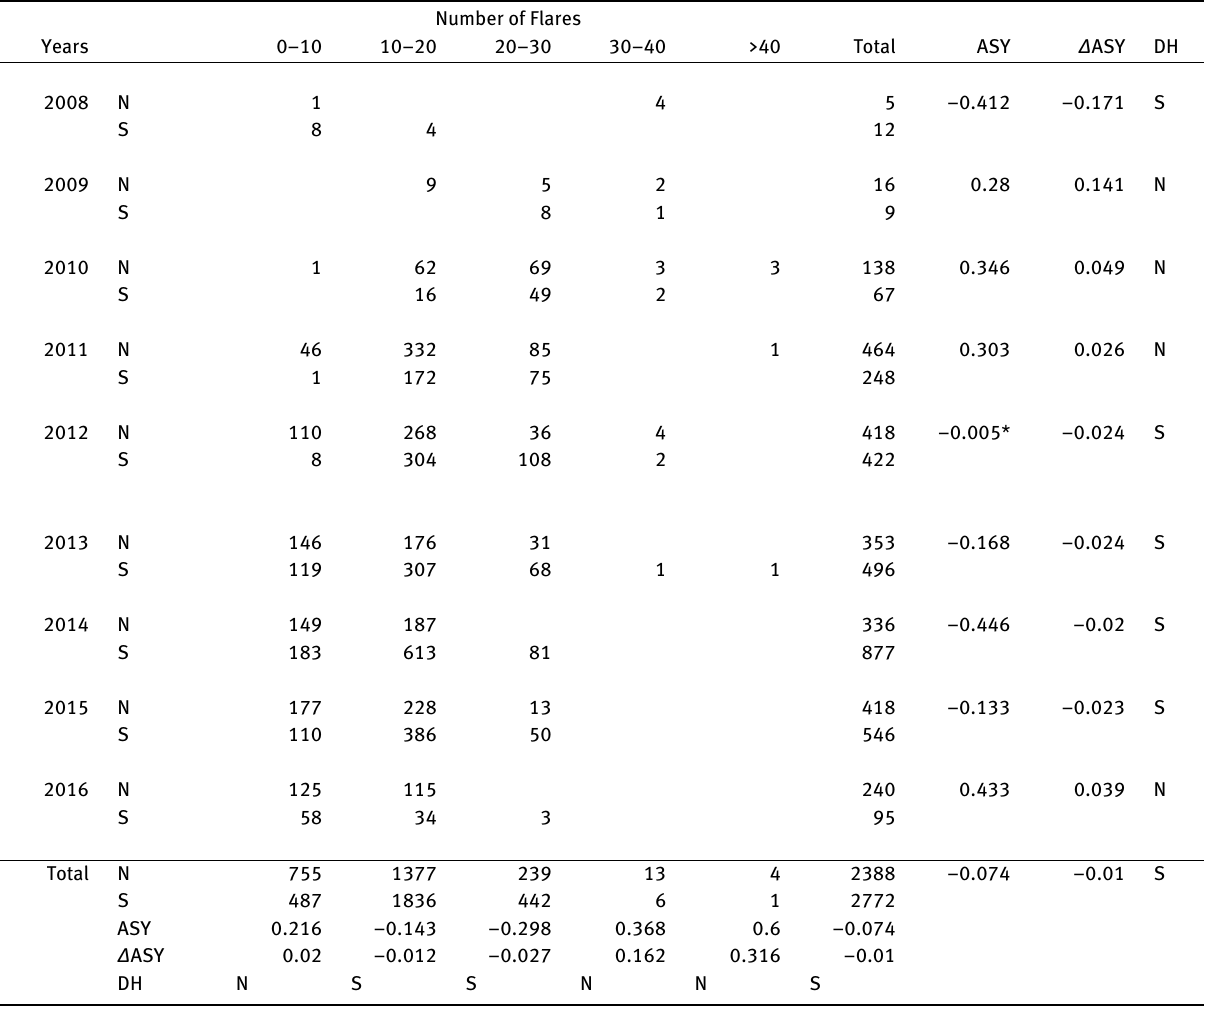
Table 2. Number of SXR flares in different latitudinal belts in northern (N) and southern (S) hemispheres for the years 2008-2016. The total number of flares in N and S hemispheres, the N-S asymmetry (ASY), the N-S asymmetry of the random distribution flares ( ∆ ASY) and the dominant hemisphere (DH) are given for each year and as well as for all latitudinal belts in the bottom of the table. Here the overall asymmetry value of −0.074 (southern dominated) was calculated using weighted average. Except in 2012 (denoted by asterisk *) all the values of asymmetry are highly significant (i.e., ASY> ∆ ASY).